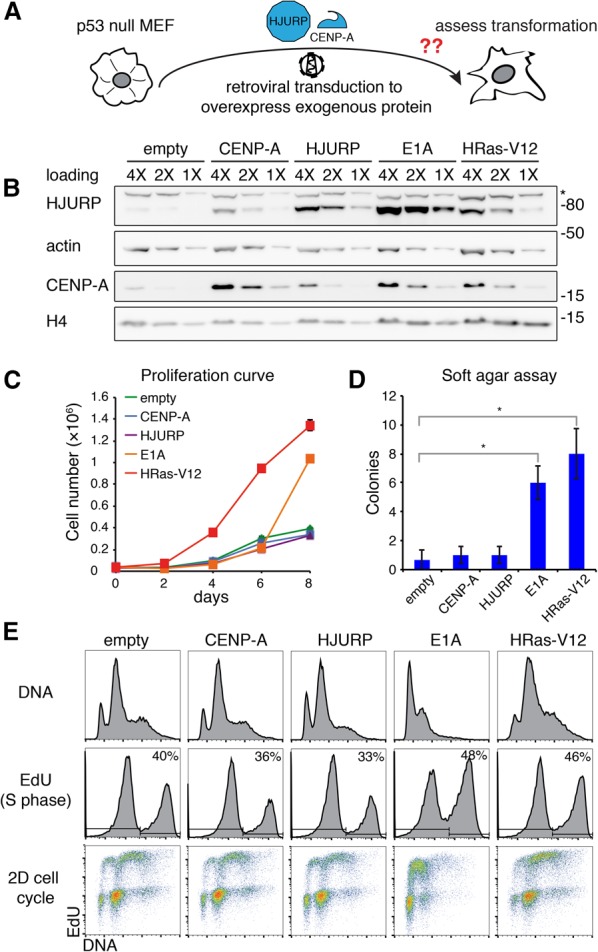
CENP-A or HJURP overexpression does not alter proliferation or cell cycle in p53-null MEFs. (A) Scheme outlining an experimental approach. Immortalized p53-null MEFs were transduced with retroviral particles encoding HJURP or CENP-A, expressed under the control of the retroviral promoter, and assessed for transformation hallmarks such as increased cell proliferation or substrate-independent cell growth. (B) Western blot of HJURP and CENP-A levels in RIPA-soluble extracts from p53-null MEFs transduced with the indicated retroviral construct 6 d after transduction and following hygromycin selection. H4 levels are also shown. Actin was used as a loading control. An asterisk marks a nonspecific band detected with the HJURP antibody. A twofold dilution series of each extract is represented by 4X, 2X, and 1X. Molecular weight protein markers are indicated at the right. (C) Proliferation curve of p53-null MEFs transduced with the indicated retroviral construct. MEFs (3 × 104) were seeded in 1 mL of growth medium on 24-well plates. The graph displays the quantified cell number ± SEM of triplicates. (D) Soft agar colony-forming assay in p53-null MEFs transduced with the indicated retroviral construct. We stained colonies with Sytox Green 4 wk after seeding. Bars represent quantification of visible colony numbers ± SEM. n = 3. (*) P < 0.05, significance determined by a t-test. (E, top panels) Cell cycle analysis by flow cytometry in p53-null MEFs transduced with the indicated retroviral construct following EdU uptake and PI (DNA) staining. The percentage of EdU-positive cells (S phase) is indicated.